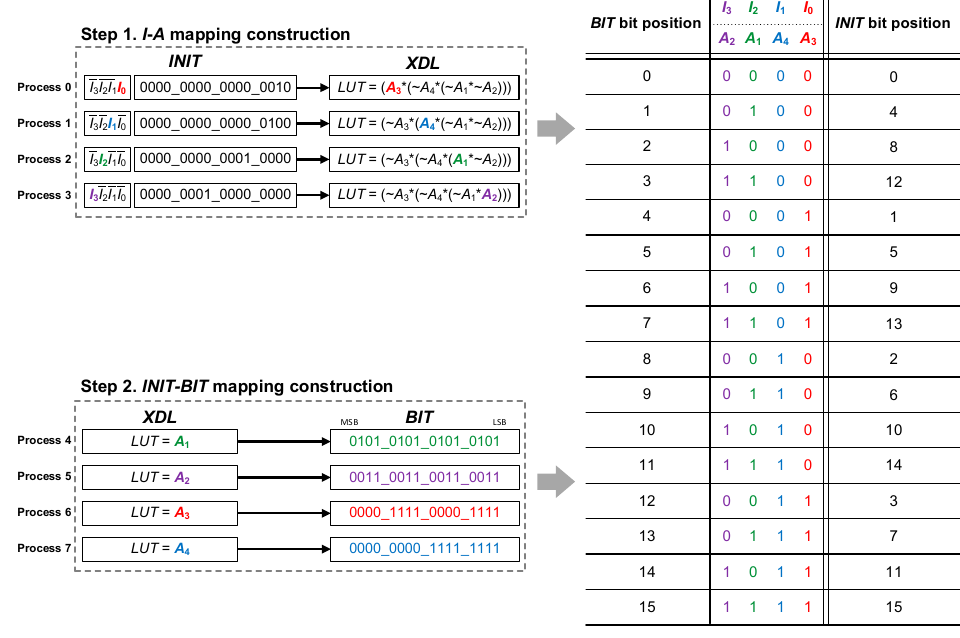
Figure 6. Mapping table construction for the proposed method.